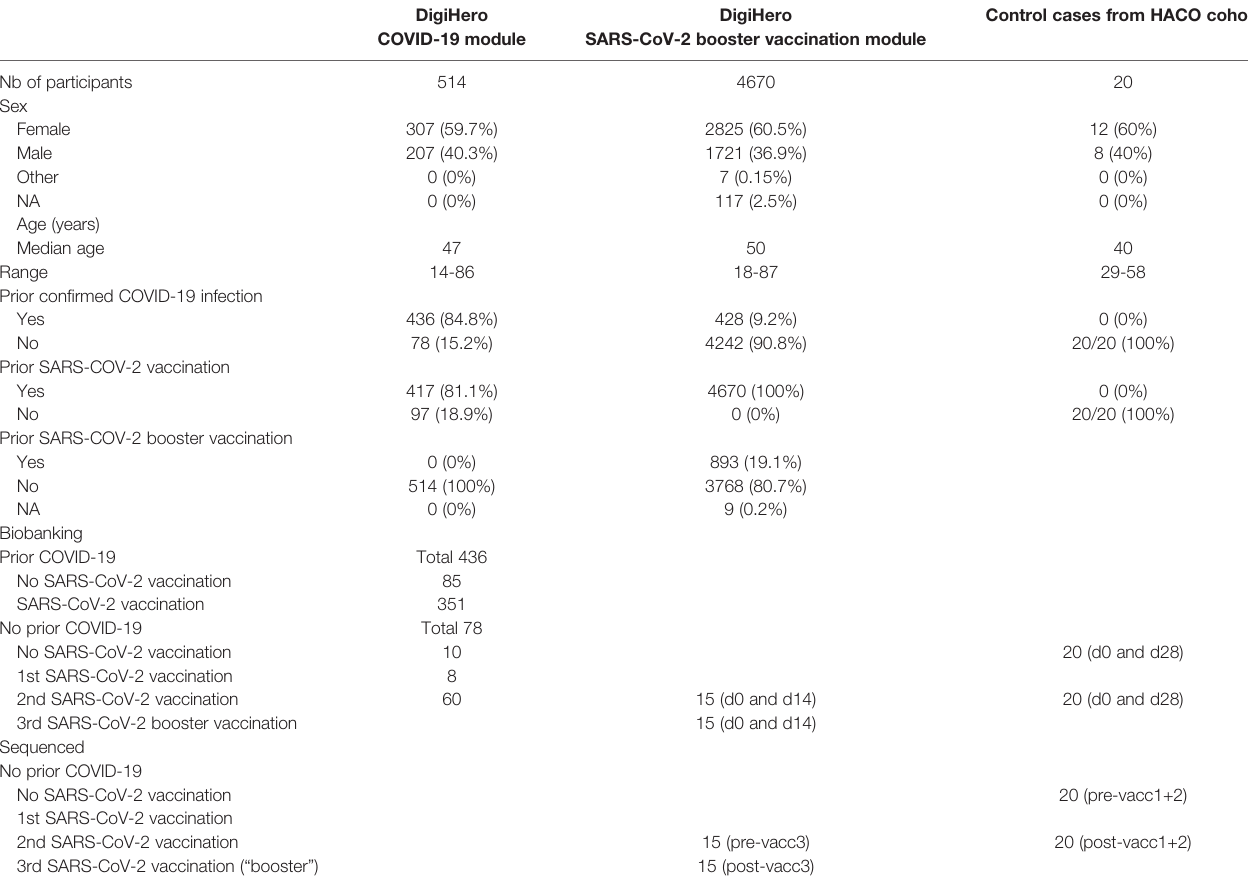
TABLE 1 | Characteristics of participants in the DigiHero COVID-19 and SARS-CoV-2 booster vaccination modules and the HACO subcohort used for